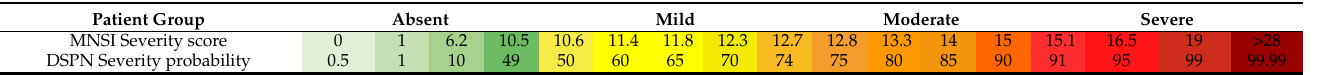
Figure 5. Nomogram based on multivariate logistic regression-based for probability prediction of DSPN severity. Nomogram for predicting DSPN severity was formed utilizing seven different predictors, namely 10-gm filament, Vibration perception (L), Vibration perception (R), Appearance of Callus, Appearance of Deformities, Previous Diabetic Neuropathy, Appearance of Fissure. Table 6. MNSI severity score from the nomogram and the corresponding severity probability of the DSPN